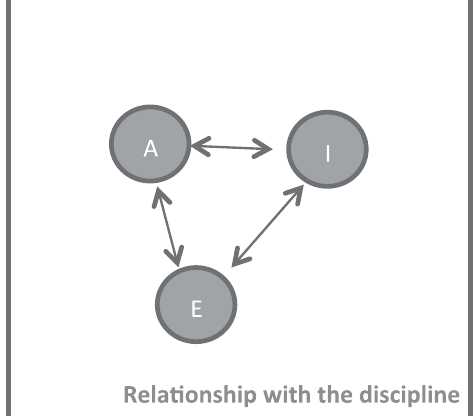
FIG. 1. A disciplinary relationship conceptualized as inter- actions between affect, identity, and epistemology. The boundary line represents the extent that a single discipline is represented by these